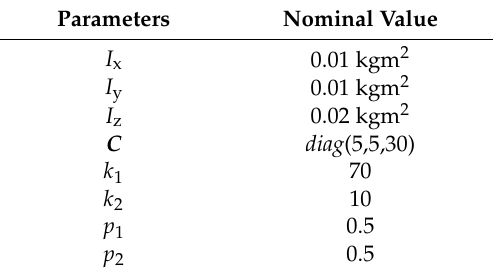
Figure 18. Deformation of quadrotor frame used in the experiments. Table 4. Control parameters used in the